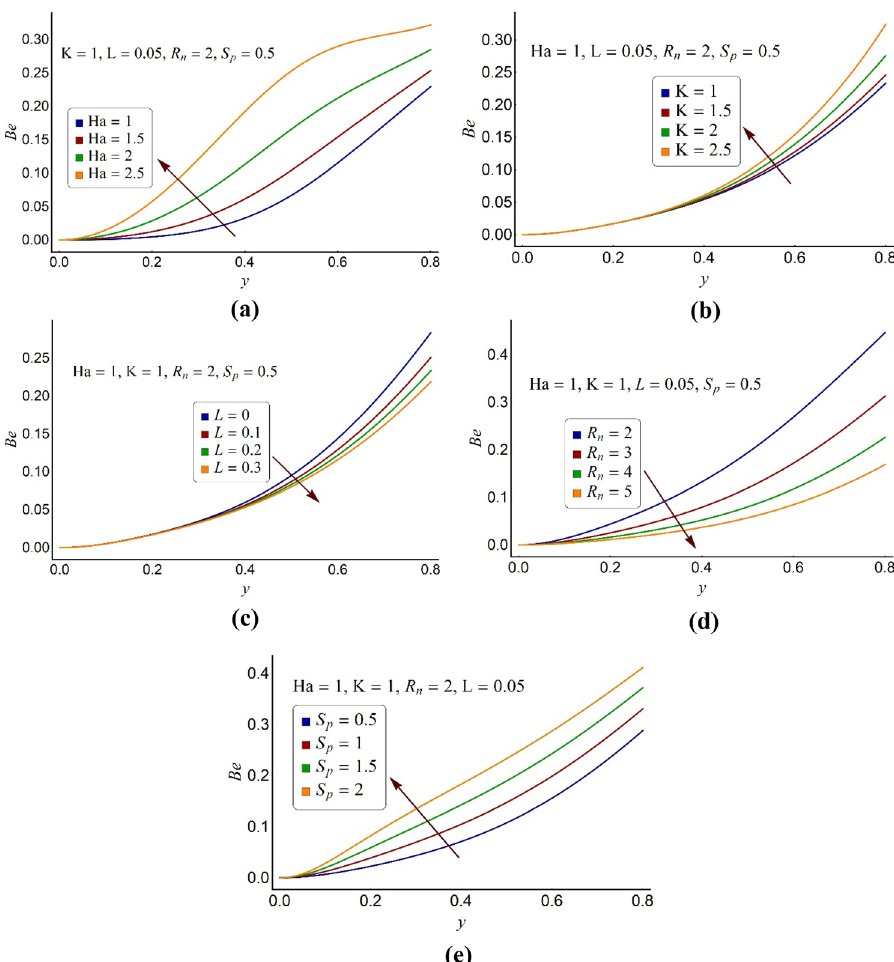
Figure 7. Alterations in the Bejan number profile of ternary fluid for various values of ( a ) Hartmann number Ha, ( b ) electroosmotic parameter K, ( c ) momentum slip parameter L , ( d ) thermal radiation number R n , ( e ) ohmic heating parameter S p